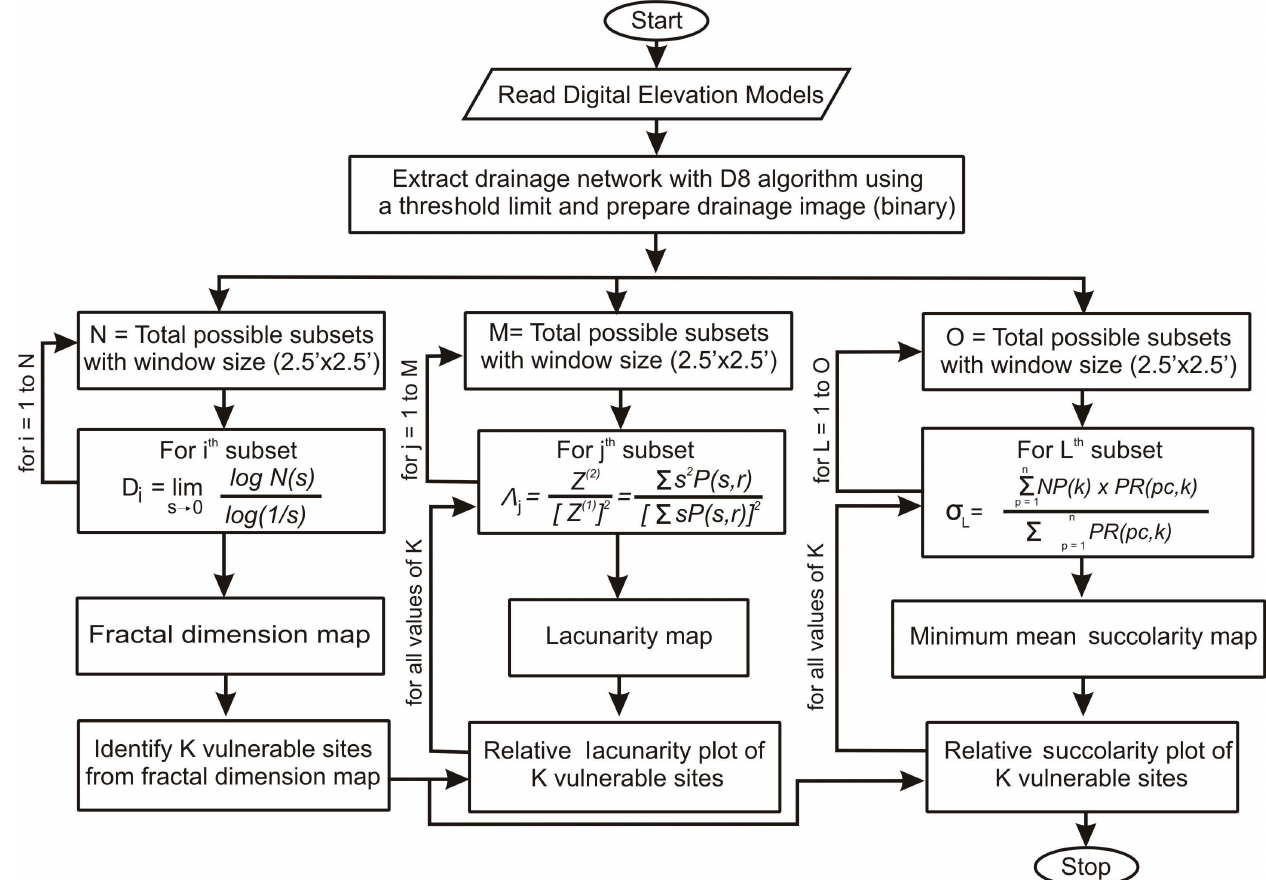
Fig. 2. Simplified flow chart of the